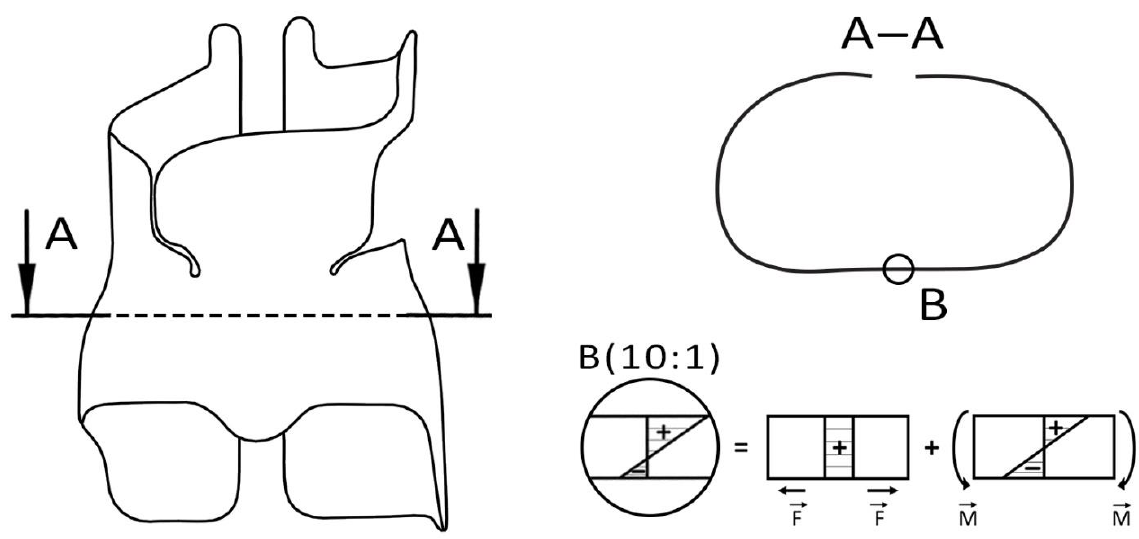
Figure 10. Stress distribution in section A–A of the front bracing wall (the upper side of diagram B corresponds to the inner side of the orthosis surface): superposition of stresses due to bending acting on moment M and force F .